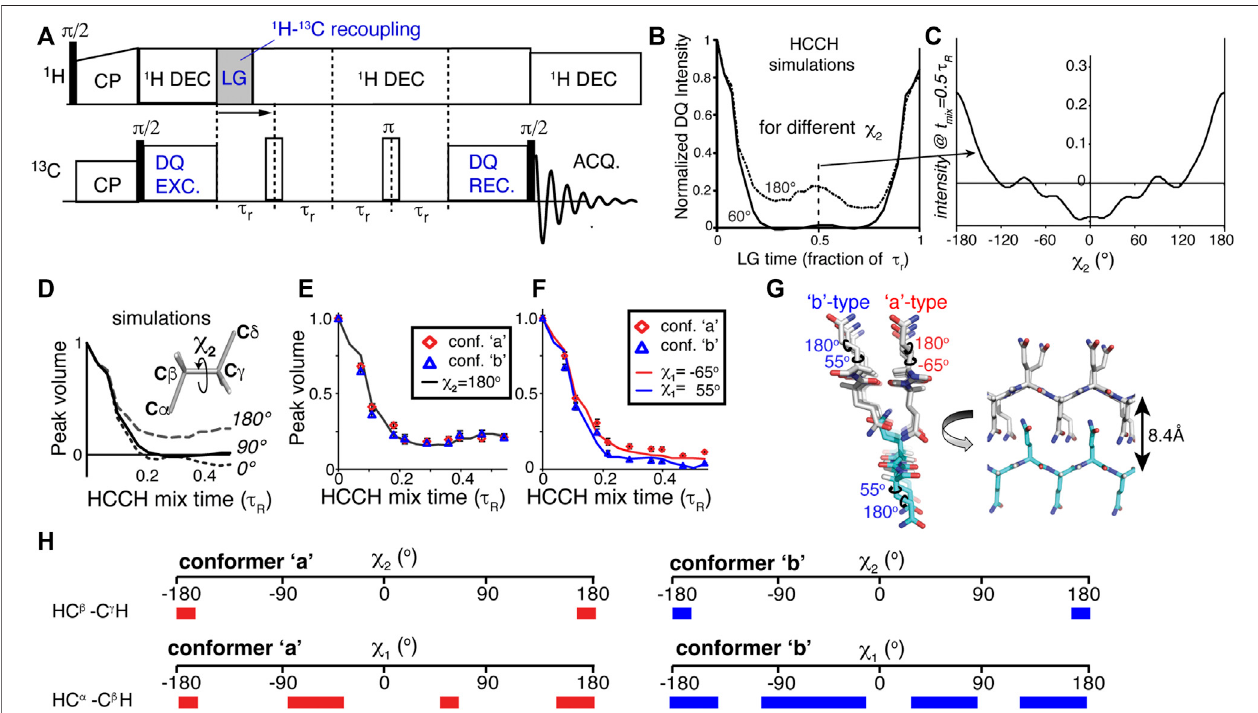
FIGURE 4 | HCCH experiments for measuring side chain angles. (A) Pulse program schematic for a HCCH experiment. (B) Simulated HCCH curves for measurement of the χ 2 angle in glutamine residues (a C β H 2 -C γ H 2 spin system), for χ 2 (cid:1) 60 or 180 ° . (C) Variation of the mid-rotor-period intensity as a function of the χ 2 angle. (D,E) Simulated and experimental data measuring the χ 2 angle of glutamine residues in the core of polyglutamine amyloid. (F) Application to the χ 1 angle in polyglutamine amyloid. (G) Visualized structural model for how the polyglutamine amyloid core is structured, based on the best- fi t dihedral angle solutions. (H) Overview of the ambiguity in some, but not all, of the measured χ angles. The colored bars indicate those angles that are consistent with the observed torsion angle curves. The red bars on the left apply to conformer ‘ a ’ , and the blue ones (right) to conformer ‘ b ’ . Figure adapted from ref. (Hoop et al., 2016) with permission.